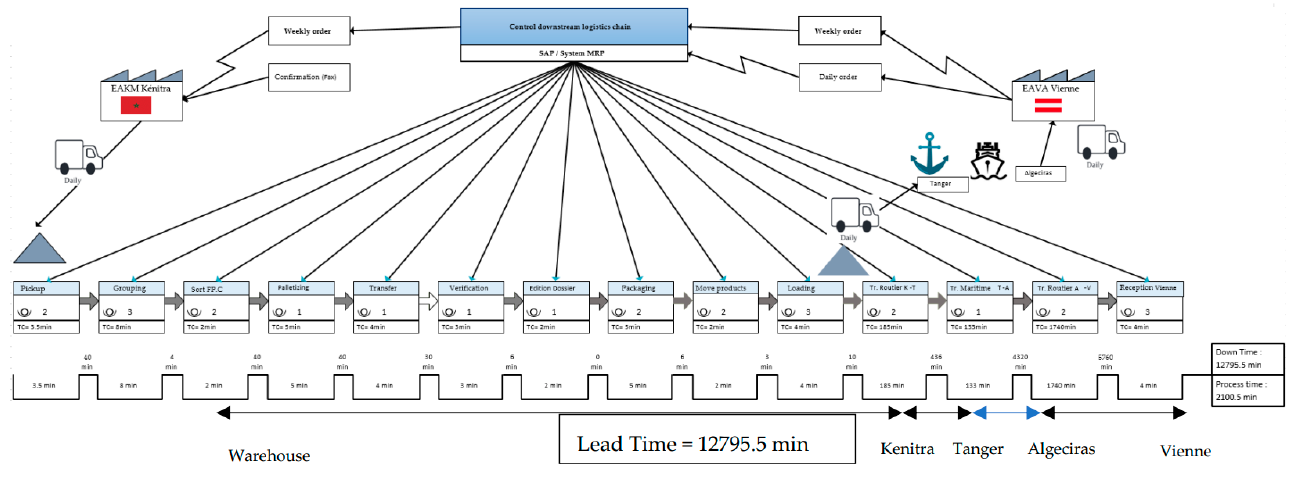
Figure 5. Mapping of the current state.